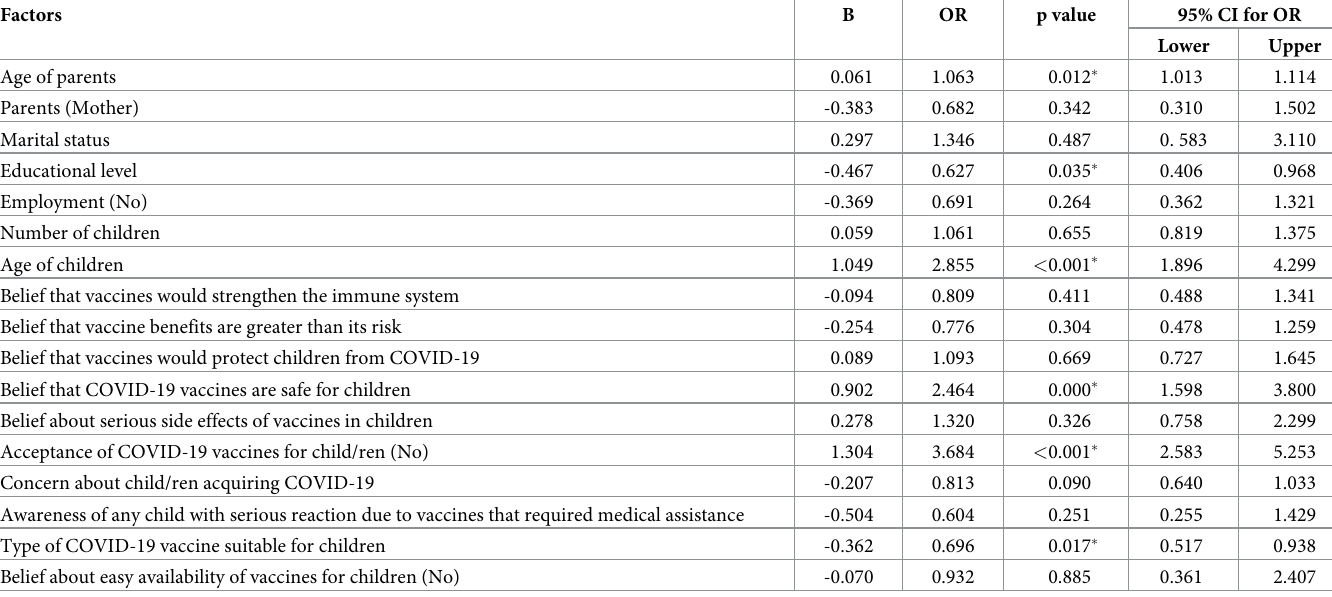
Table 5. Multivariate logistic regression analysis of factors affecting decision of vaccinating children against COVID-19 ( n = 500).